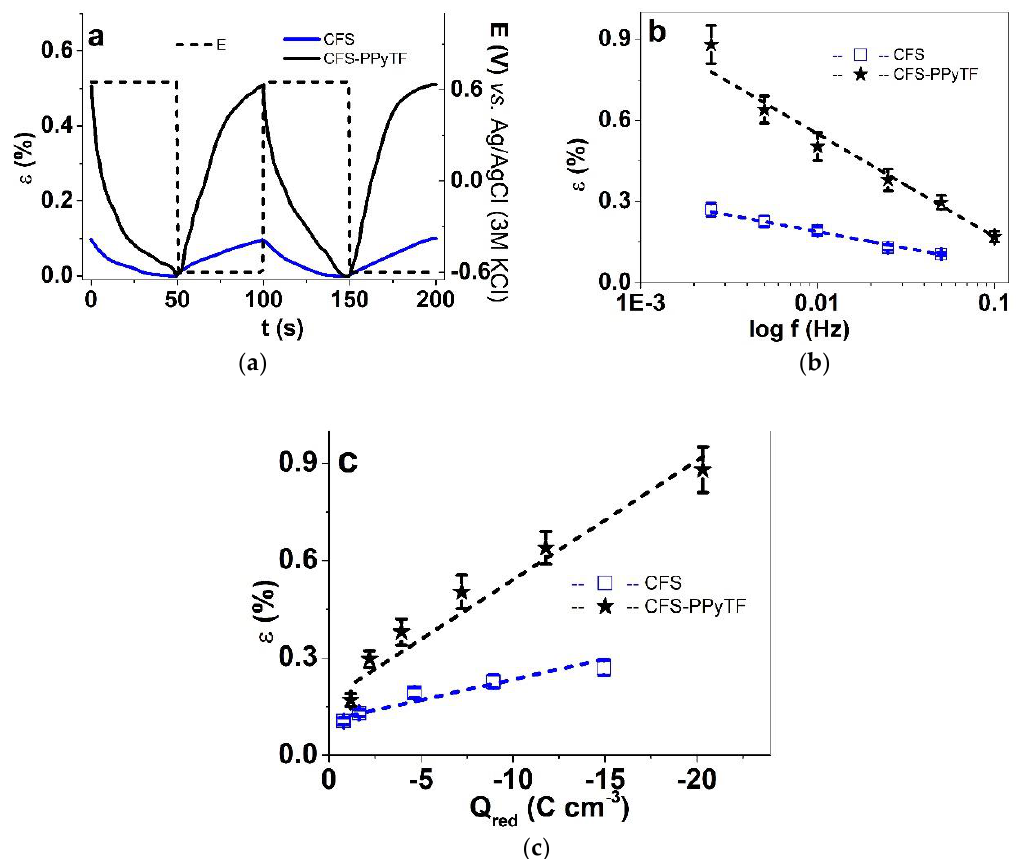
Figure 5. Square wave potential steps response in potential range 0.65 V to − 0.6 V in CCM electrolyte showing in ( a ) the strain ε curves (3rd–5th cycles) of CFS (blue) and CFS-PPyTF (black) with potential E (dashed) against time t (frequency, 0.01 Hz). At frequencies 0.0025 Hz to 0.1 Hz the strain of CFS (blue, (cid:3) ) and CFS-PPyTF (black, (cid:70) ) against logarithm of frequency are shown in ( b ). The strain ε against the charge density Q red is shown in ( c ). The dashed lines in b and c represent the linear fit (y = a + b*x, with adj. R 2 of 0.91 for CFS-PPyTF and 0.93 for CFS), shown as visual